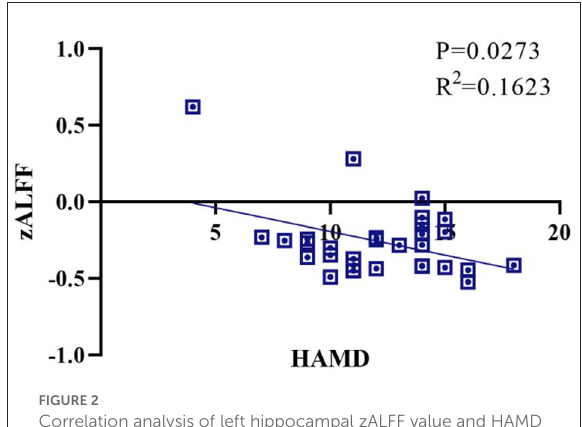
FIGURE2 Correlation analysis of left hippocampal zALFF value and HAMD score.